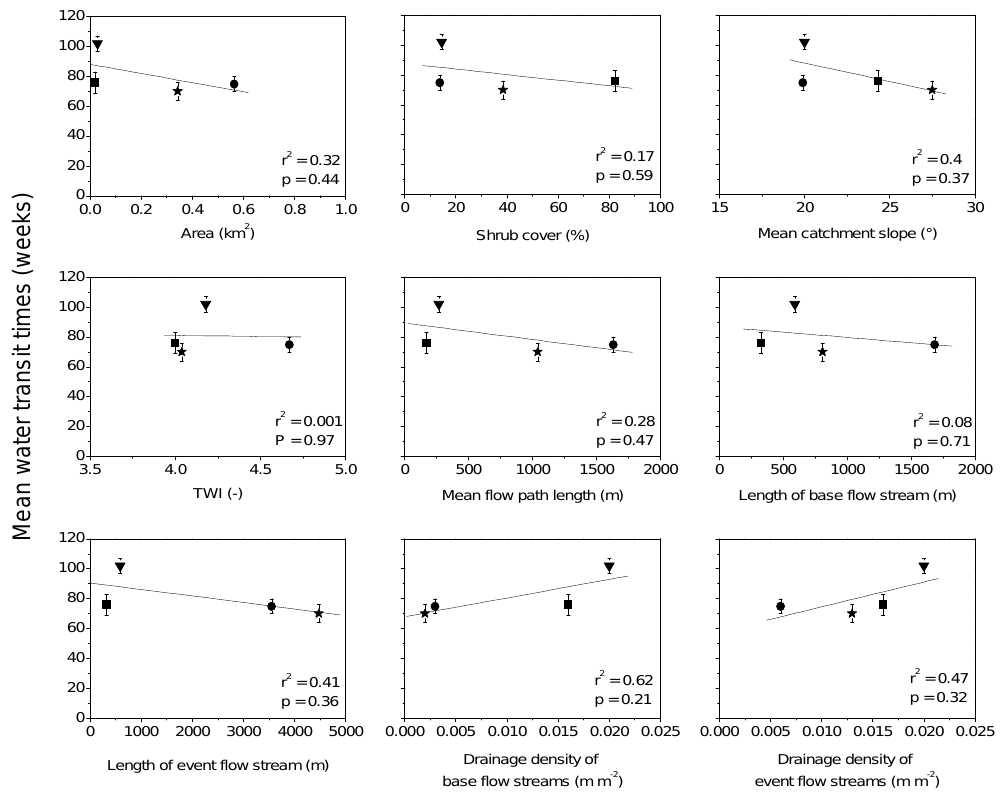
Fig. 8. Correlation of MTT with topographic indices and shrub cover. Average MTTs of parameter sets C to E are shown. (cid:4) = Ch¨amleten, • = Wallenboden, F = Bonegg, H = Laubg¨adem. Micro catchment area and shrub cover data from Fercher (2013) and van den Bergh et al. (2011),